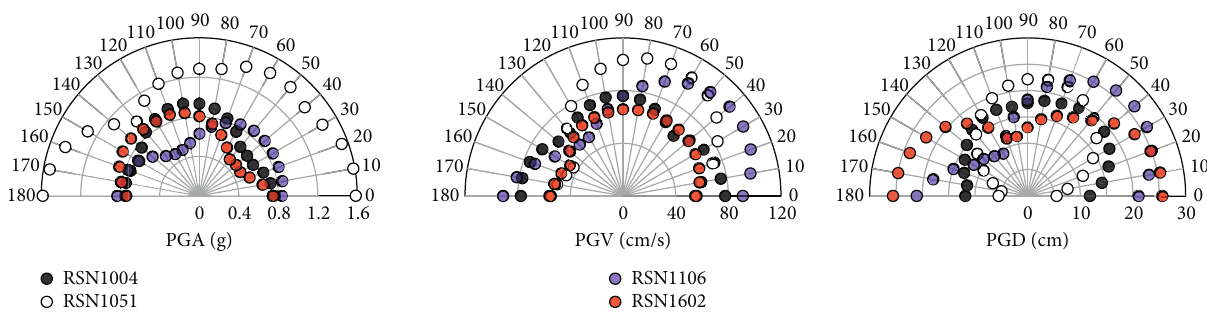
Figure 4: The peak values of pulse-type ground motions varied with